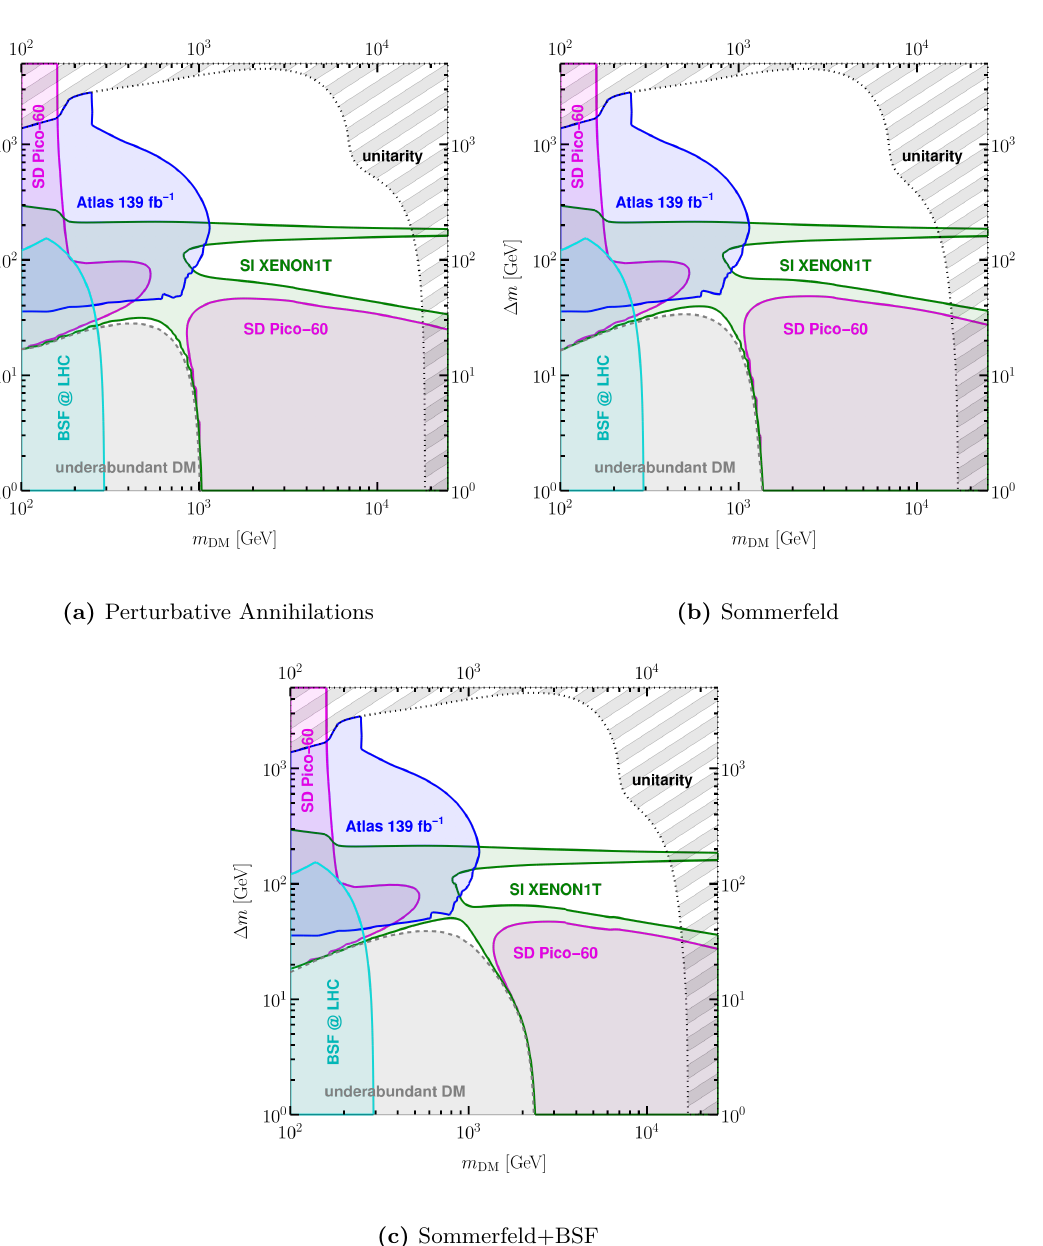
Figure 10. Exclusion limits from various experiments on the u R -version of the model in the ( m ∆ m ) -plane. For each point in the plane, we determine the smallest value of g such that DM , DM DM is not overproduced. If this lower bound on g contradicts the limits from spin-independent DM DD (spin-dependent DD, prompt-collider searches, perturbative unitarity, stoponium searches), it is colored in green (magenta, blue, black, cyan). We show the experimental limits obtained considering perturbative annihilations, the SE and the SE+BSF. The gray dashed line divides the parameter space into two regions. Above, the observed relic density can be generated via thermal